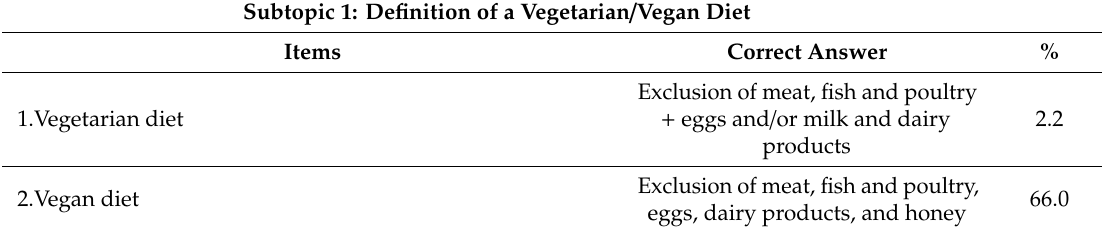
Table 3. Absolute and percentage correct answers regarding knowledge about vegetarian diets.